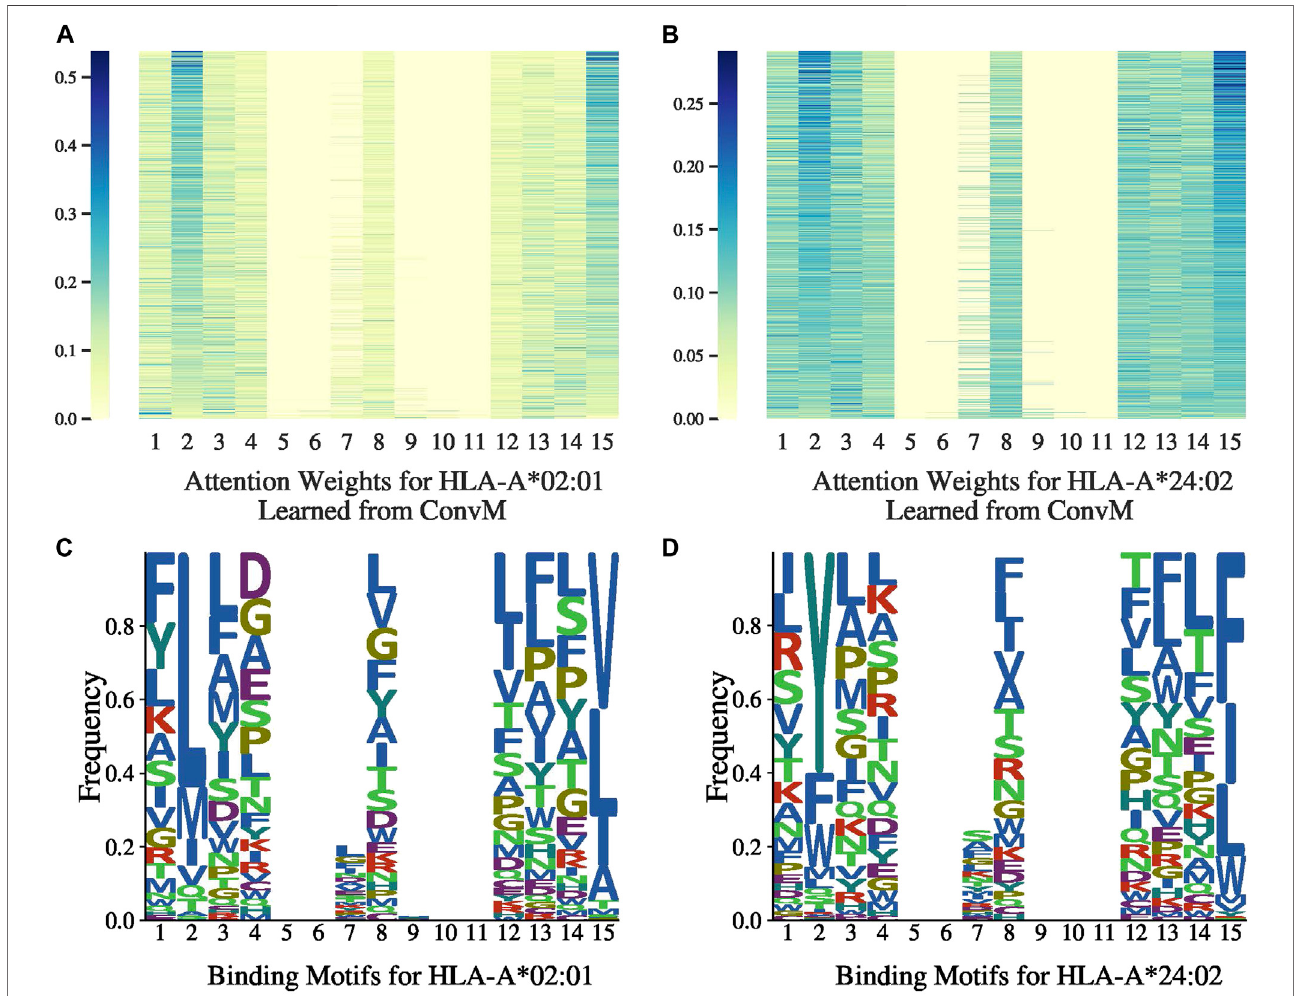
FIGURE 3 | Attention weights and motifs for HLA-A*02:01 and HLA-A*24:02.